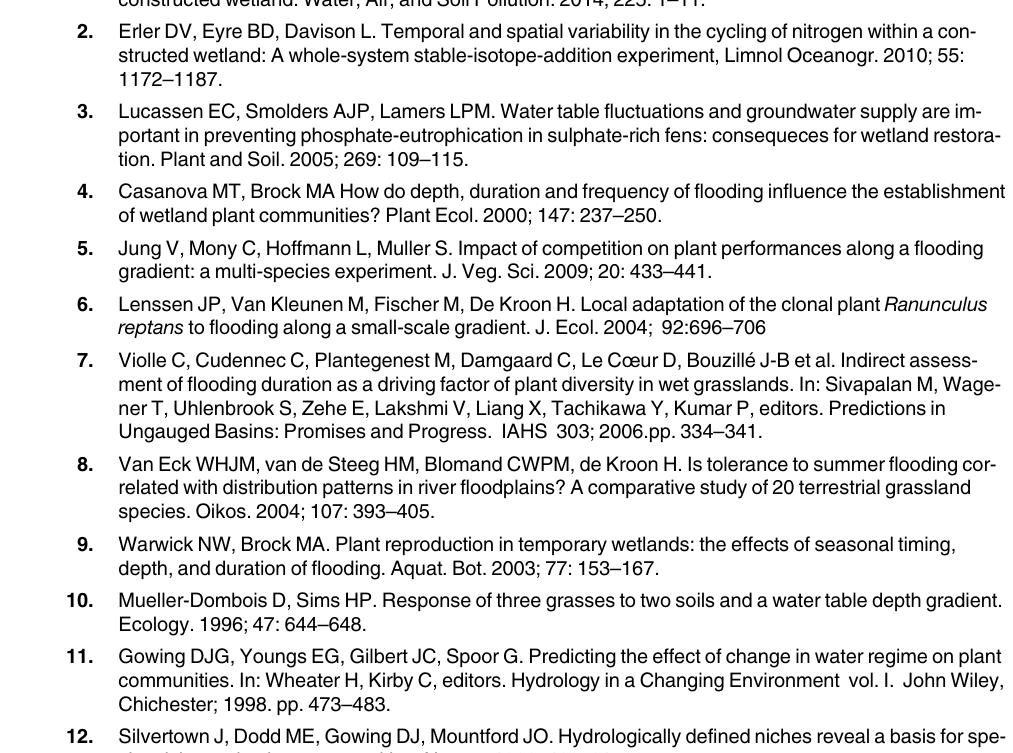
S1 Table. Estimated effect of flooding and drought on species growth ( a petitive effect ( c ) summarized by the marginal posterior distribution of the parameters. If 1 is greater than zero, then growth of the species increased with SEV. Likewise, if c a 1 than zero, then the competitive effect of the species increases with SEV. Parameters significant- ly deviated from zero appear in bold font. The species considered in pair in the model that are followed by similar letters showed non-significantly different